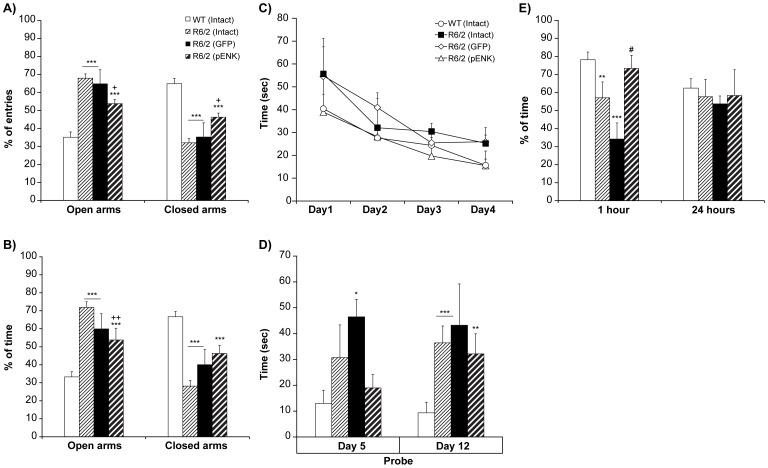
Elevated plus maze, Barnes maze, and Novel object recognition test in different groups of R6/2 and WT mice.Entry and time spent in open and closed arms of elevated plus maze (A, B): At week 8 of age, all R6/2 mice showed more percentage of entries (A), and spent more time in the open arm (B) compared with WT. In R6/2 mice having striatal overexpression of pENK, a reduction in percent of entries (A) and percent of time elapsed (B) in the open arms was observed compared with intact age-matched R6/2 mice. The percentage of entries and the proportion of time spent in the closed arms was exactly the reverse of what was seen for the open arms. Data are presented as mean percent of entries or mean percent of time spent in the open or closed arms / time spent in all four arms ± SEM. *** p<0.0005 vs. WT; + p<0.01, ++ p<0.005 vs. R6/2 (Intact). Learning and memory in Barnes maze (C, D) and Novel object recognition test (E): In Barnes maze performance, started at week 7 of age, no difference was observed in latency to find escape hole between different groups during trial days (C). At probe day 5th (D), R6/2 mice having striatal injection of rAAV2-GFP showed increased latency to find target hole compared to WT and pENK-injected R6/2 mice. Whereas no difference was detected between pENK-injected R6/2 mice and WT, while intact R6/2 mice tended to spent longer time to reach the target hole compared with WT counterparts. At probe day 12th (D), the time latency to find target hole was higher in all groups of R6/2 than WT. Novel object recognition test, at week 9, showed that in 1 hour retention test (E), intact R6/2 mice spent less time to explore the novel object compared to WT. Less preference toward novel object was even more pronounced in GFP-injected R6/2 mice compared with WT and pENK-injected group. Interestingly, recognition of novel object was considerably improved in R6/2 mice having striatal overexpression of pENK. Data are presented as percent of the time spent exploring the new object/ total time exploring new and familiar objects ± SEM. * p<0.01, ** p<0.005, *** p<0.0005 vs. WT; + p<0.01, ++ p<0.005 vs. R6/2 (Intact); # p<0.01 vs. R6/2 (GFP).